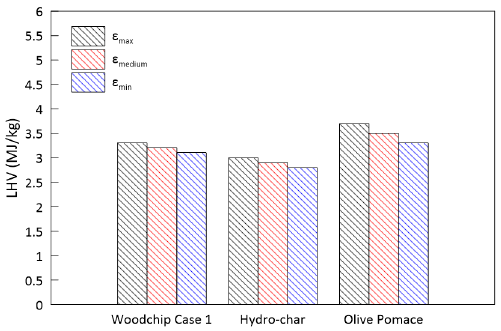
Figure 16. Syngas LHV (on a daf basis) at different ε for woodchip case 1, hydro-char from green waste, olive pomace.